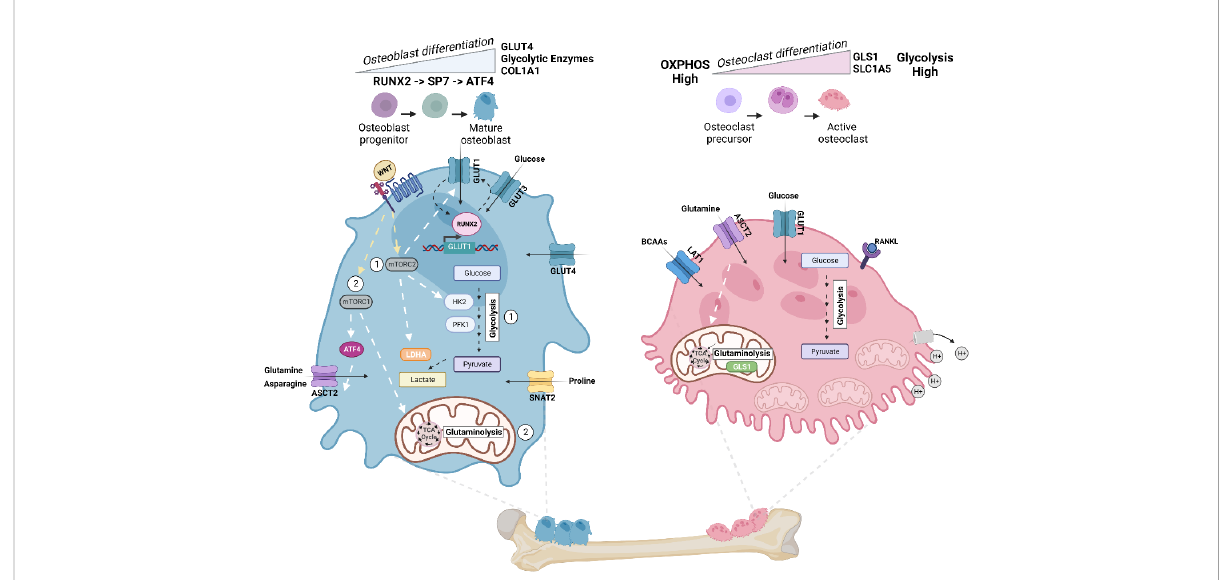
FIGURE 3 Energy metabolism in osteoblast and osteoclast. Metabolic pathways rewired in osteoblast (Left) and osteoclast (Right) during cellular differentiation. Left: In mature osteoblasts, glycolysis accounts for 80% of ATP production. Osteoblast precursors sequentially express the transcription factor RUNX2, followed by Sp7 (osterix (Osx)), and collagen-promoting ATF4 at late stages of differentiation. Illustration depicts the feed-forward mechanism where high intercellular glucose inhibits the proteasomal degradation of RUNX2, and RUNX2 increases the levels of GLUT1 transcription. WNT signaling regulates osteoblast activity and has been shown to (1) activate glycolytic enzymes (HK2 and PFK1), GLUT1, and LDHA via mTORC2 and (2) promote glutaminolysis and TCA cycle activation via mTORC1 and downstream regulation of ATF4 and glutamine transporter ASCT2 ( SLC1A5 ). Import of asparagine via ASCT2 and proline via SNAT2 ( SLC38A2 ) also facilitates osteoblast differentiation. Right: To dissolve bone and degrade collagen, osteoclasts require the generation of protons (H+) by hydrolyzing ATP. Thus, osteoclasts exhibit a signi fi cant demand for ATP and contain a high number of mitochondria. ATP demand is met by upregulating both glycolysis and glutaminolysis, and differentiation increases glycolysis and expression of glumaminase 1 (GLS1) and ASCT2. Mid-late stage osteoclast differentiation is also dependent on increased branched chain amino acid (BCAA) pools. Figure was created with